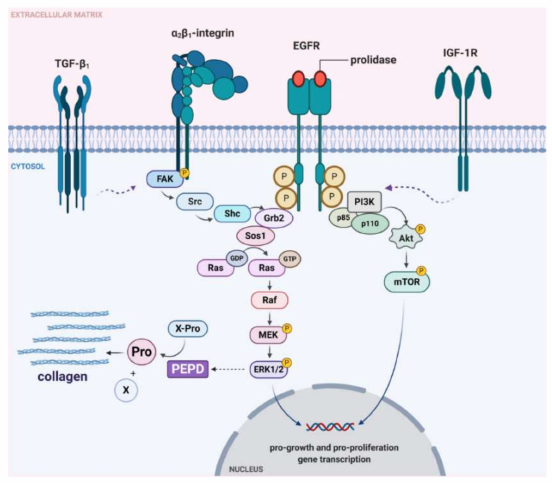
Figure 10. Graphical illustration of prolidase-dependent EGFR, β 1 -integrin receptor, TGF- β 1 , and IGF-1R-downstream signaling. Under experimental conditions of mechanically damaged HaCaT cells, prolidase causes activation of the ERK1 / 2 and PI3K / Akt / mTOR pathways resulting in increased collagen biosynthesis and cell proliferation and migration. Created with